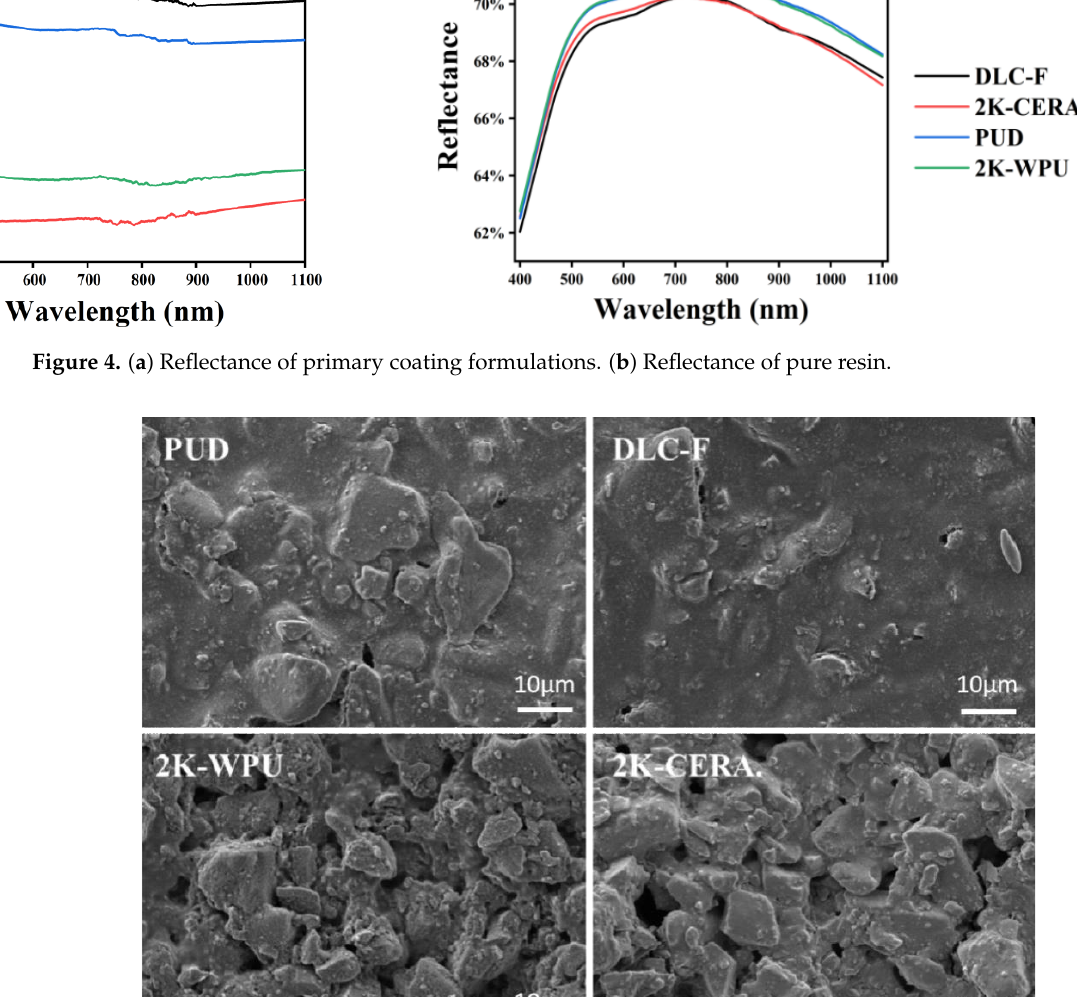
Figure 5. SEM of PUD, DLC-F, 2K-WPU, and 2K-CERA. film. The scale bar represents 10 µm.